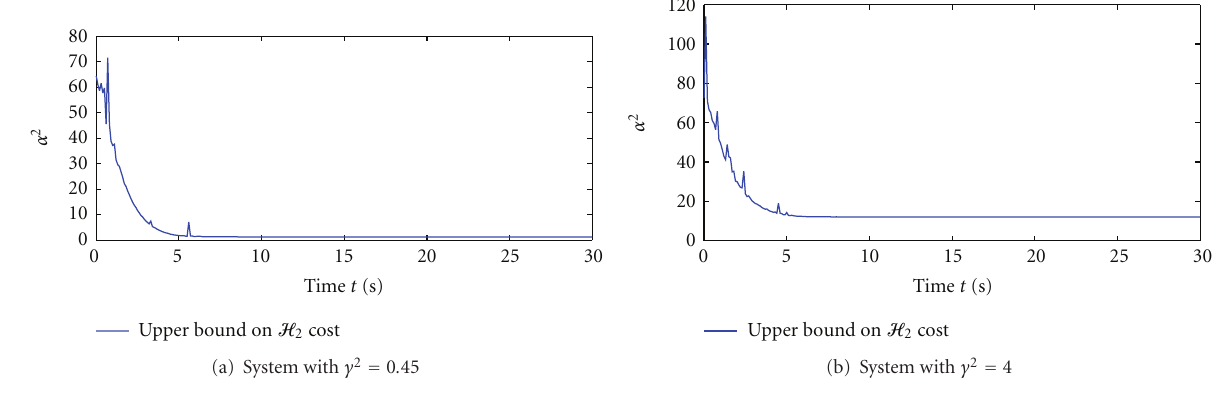
Figure 7: Upper bound on H 2 cost function for coupled spring-mass